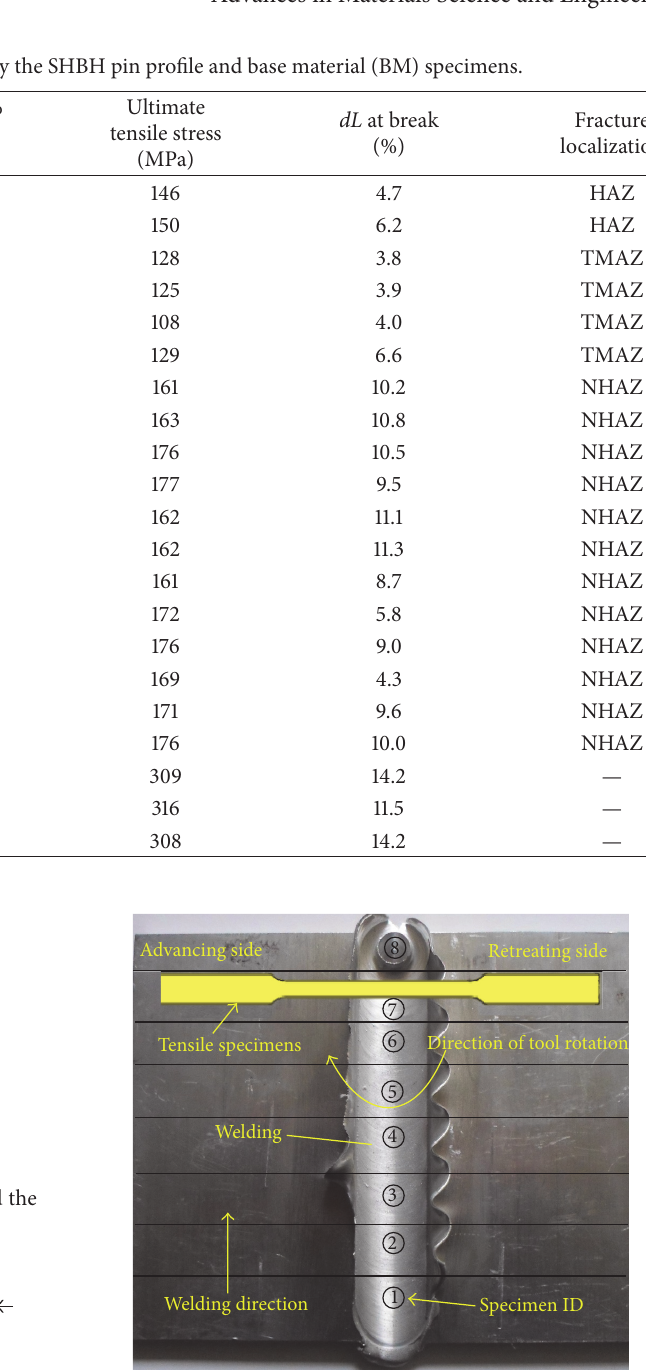
Figure 5: Zones for the tensile specimen along the welding line. Direction of welding, advancing and retreating sides, and direction of tool